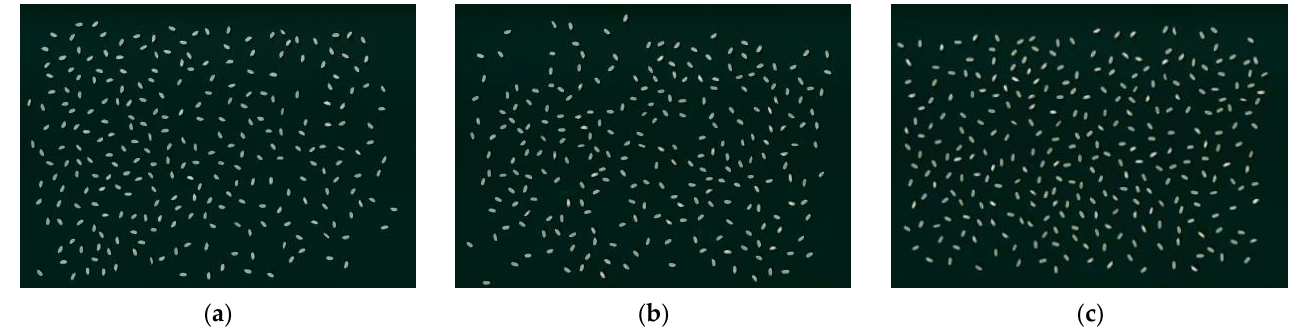
Figure 1. Images of the original multi-grain rice. ( a ) Well-milled. ( b ) Reasonably well-milled. ( c ) Substandard. ( c )